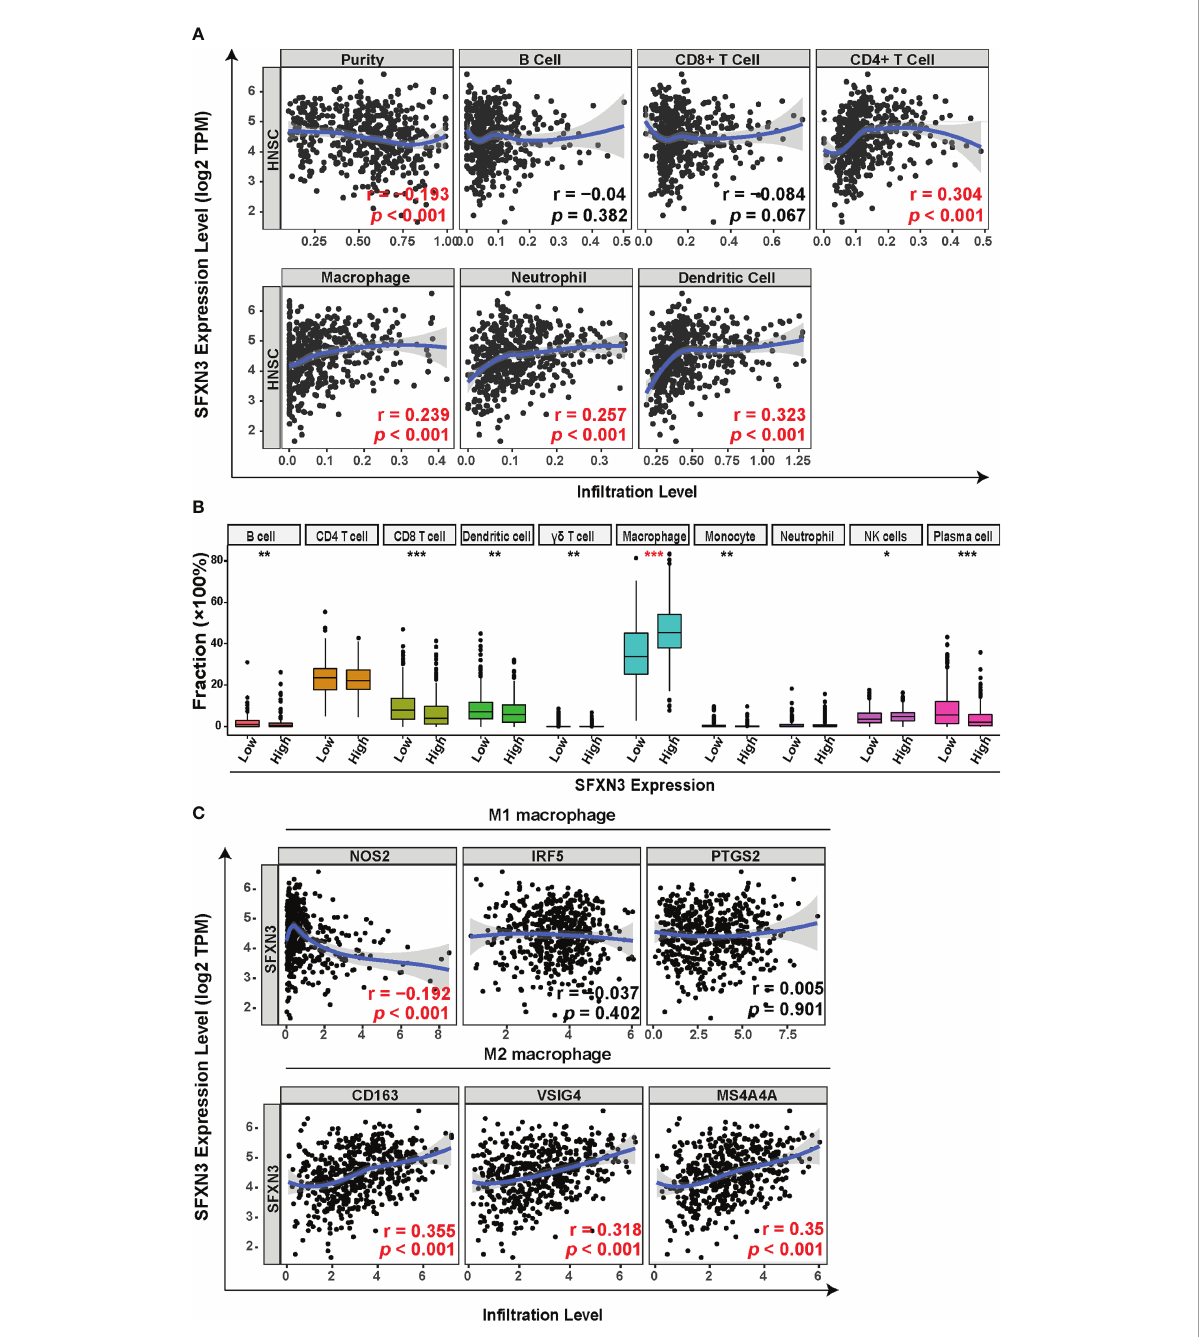
FIGURE 2 Correlation between SFXN3 expression with tumor immune cell in fi ltration in patients with head and neck squamous cell carcinoma (HNSC). (A) Tumor Immune Estimation Resource (TIMER) was used to analyze the correlation between SFXN3 expression and immune effector cells. (B) Tumor-in fi ltrating immune cells in HNSC samples were estimated using the CIBERSORT algorithm. (C) Correlation analysis of SFXN3 expression with the markers of M1 or M2 polarized phenotypes of macrophages. * p value < 0.05; ** p value < 0.01; *** p value <